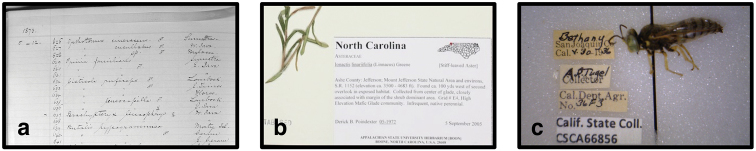
Example biocollections source images showing (a) The Natural History Museum, London bird specimen ledger; (b) The Southeast Regional Network of Expertise and Collections herbarium sheet label; (c) Calbug specimen and label image.